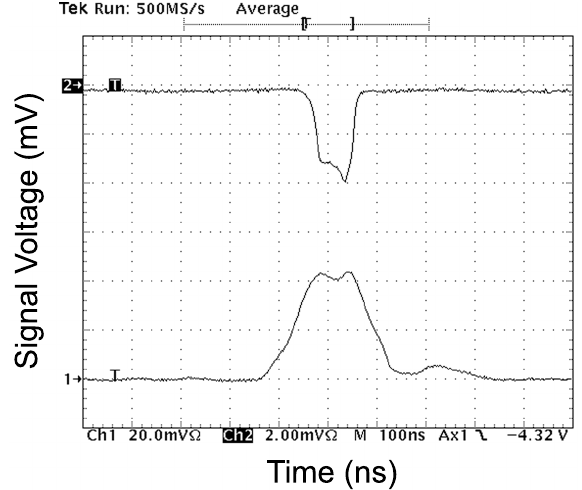
FIG. 12. Faraday cup measurement of the photoelectron cur- rent. The upper trace is the photoelectron signal from the Faraday cup, and the lower trace is the laser signal from a photodiode. The horizontal scale is 2 ns (cid:1) div, and the vertical scale is 200 mV (cid:1) div for the upper trace and the 500 mV (cid:1) div for the lower trace. This traces shows 7 pC of